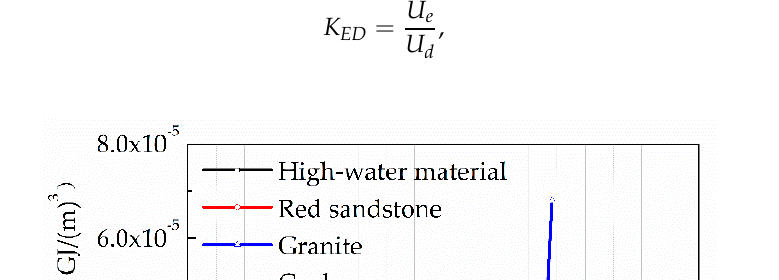
Figure 8. The dissipation energy ratios and elastic energy ratios for the five rock materials.